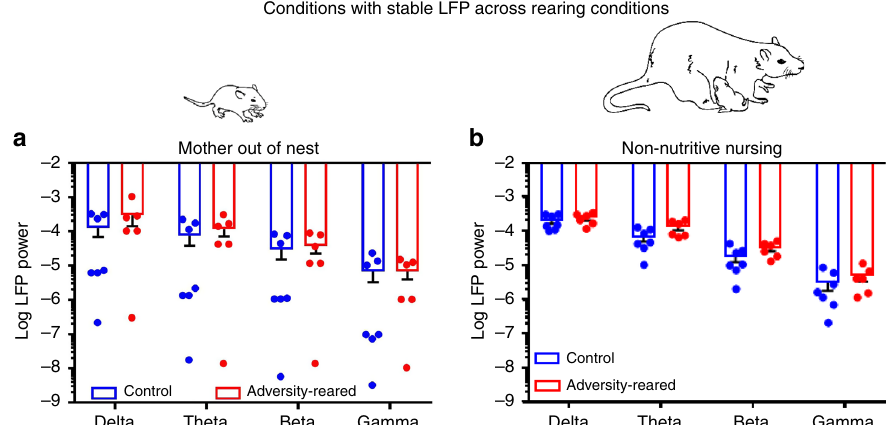
Fig. 4 Stable cortical oscillations across rearing conditions during speci fi c behavioral states. a When the pup is alone/away from the mother, LFP power does not differ between rearing conditions. b Cortical LFP power did not differ between conditions when pups are non-nutritively nursing. This measure ( “ baseline ” ) was used to normalize evoked responses to maternal inputs. Bars indicate mean ± SEM. Source data are provided as a Source Data fi